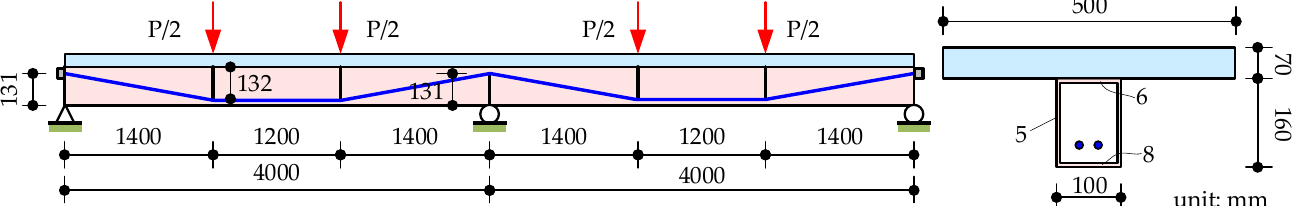
Figure 15. Structural details of specimen PCCB-4.